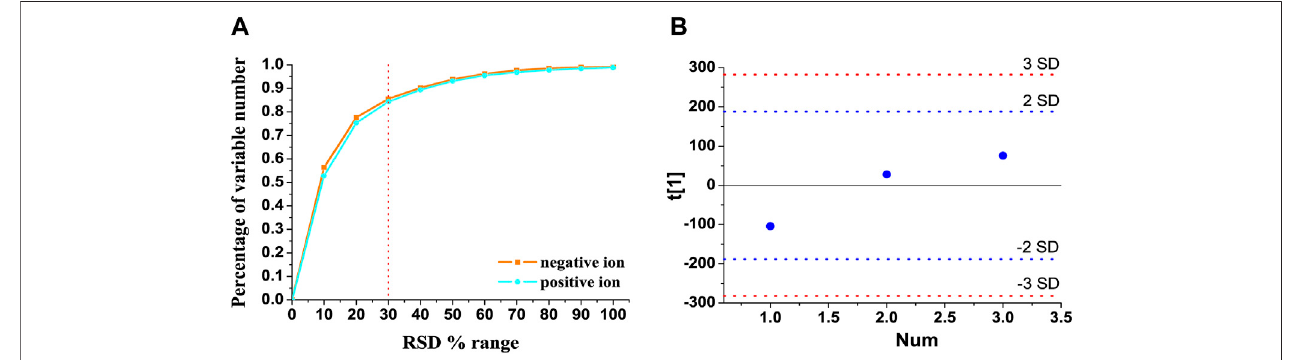
FIGURE 1 | Method validation of UHPLC-Q-extractive MS analysis. (A) RSD distribution of accumulative percentage of detected variable numbers in the pooled qualitycontrol(QC)samples. (B) Time-seriesdependencyofthe fi rstPCAcomponentt[1]ofQCsamples(blue)withinthewholeanalyticalrun.Blueandredlinesindicate the 2 and 3 SD limits of peak area intensities,